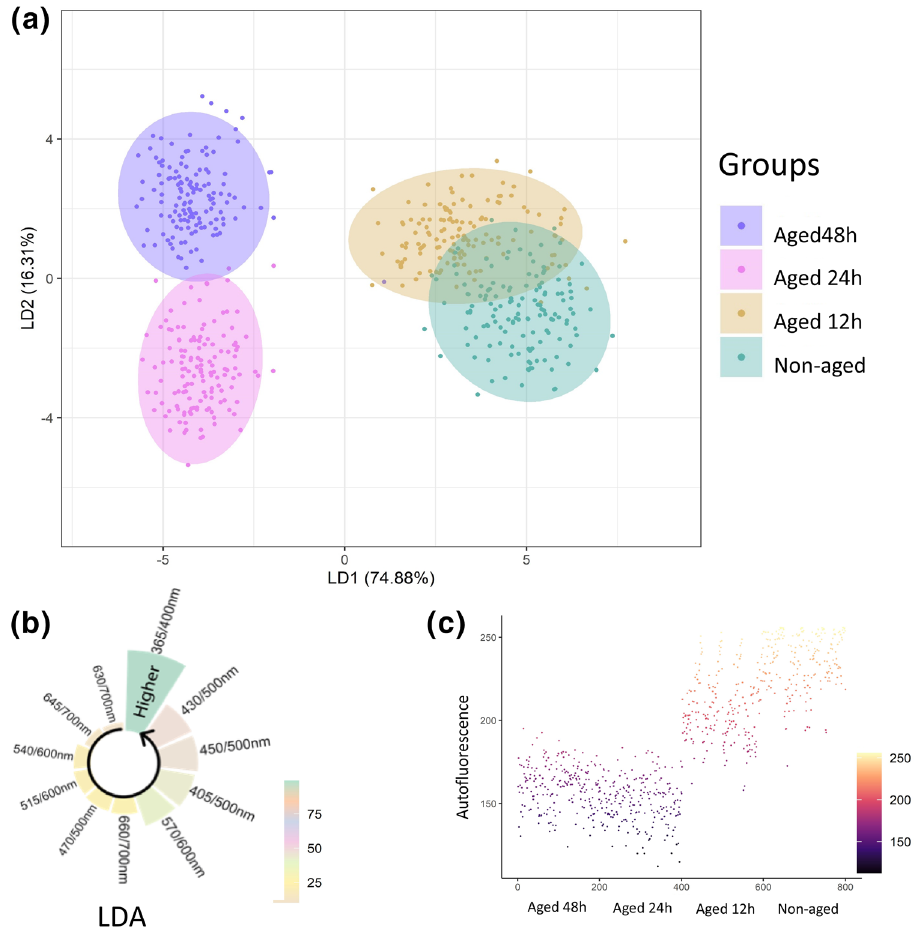
Figure 5. Linear discriminant analysis (LDA) for autofluorescence-spectral data in soybean seeds using different excitation-emission combinations (a) . Importance of each excitation-emission combination to discriminate non-aged seeds from seeds aged for 12 h, 24 h and 48 h (b) . Scatter plot with the representation of the values of each variable based on autofluorescence data using 365/400 nm combination (c) ( n = 200